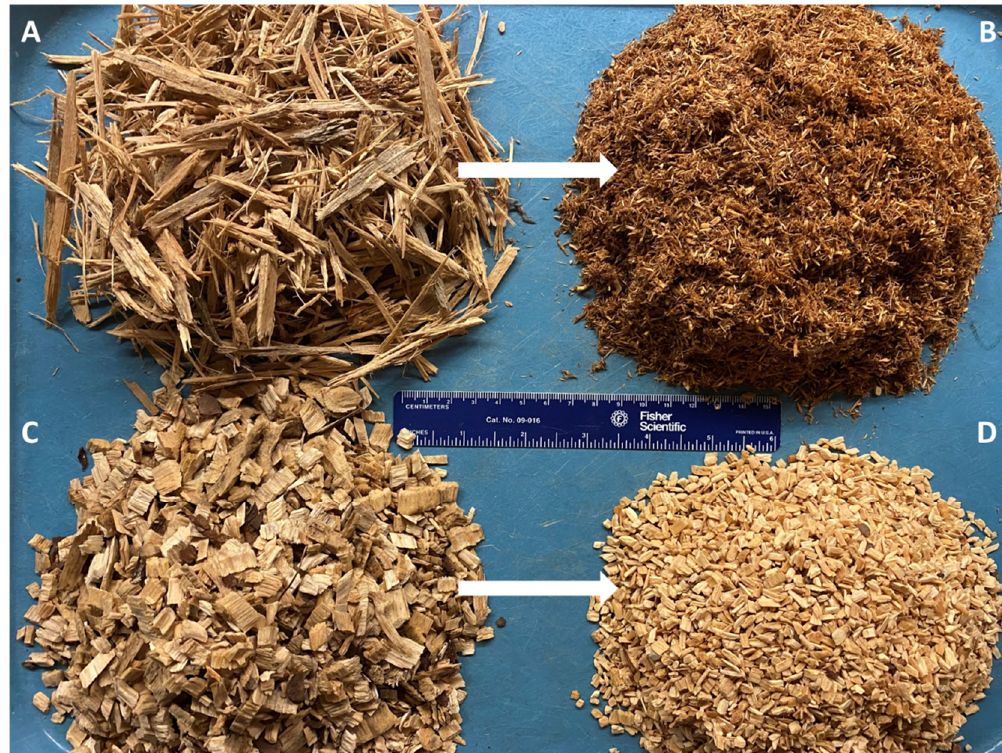
Figure 2. Pre and post hammer mill processing on the shredded pine wood (SPW) and pine wood chips (PWC). Shredded wood ( A ) passed through the hammer mill to produce SPW ( B ). Chipped pine wood ( C ) is passed through a hammer mill to produce PWC ( D ).